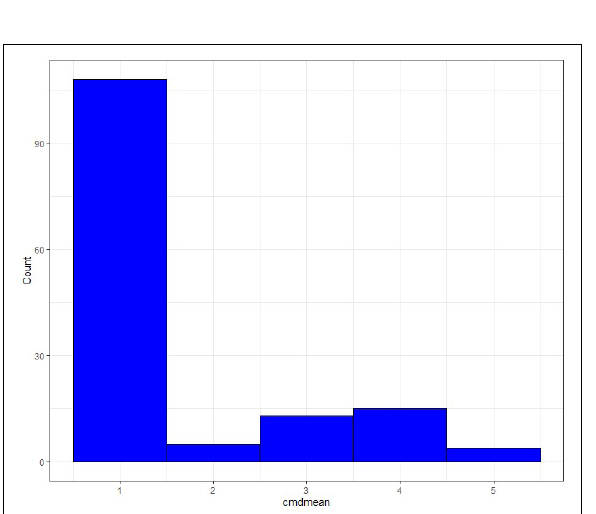
Figure 2: Frequency distribution of genotypes for cassava mosaic disease severity scores (1–5).